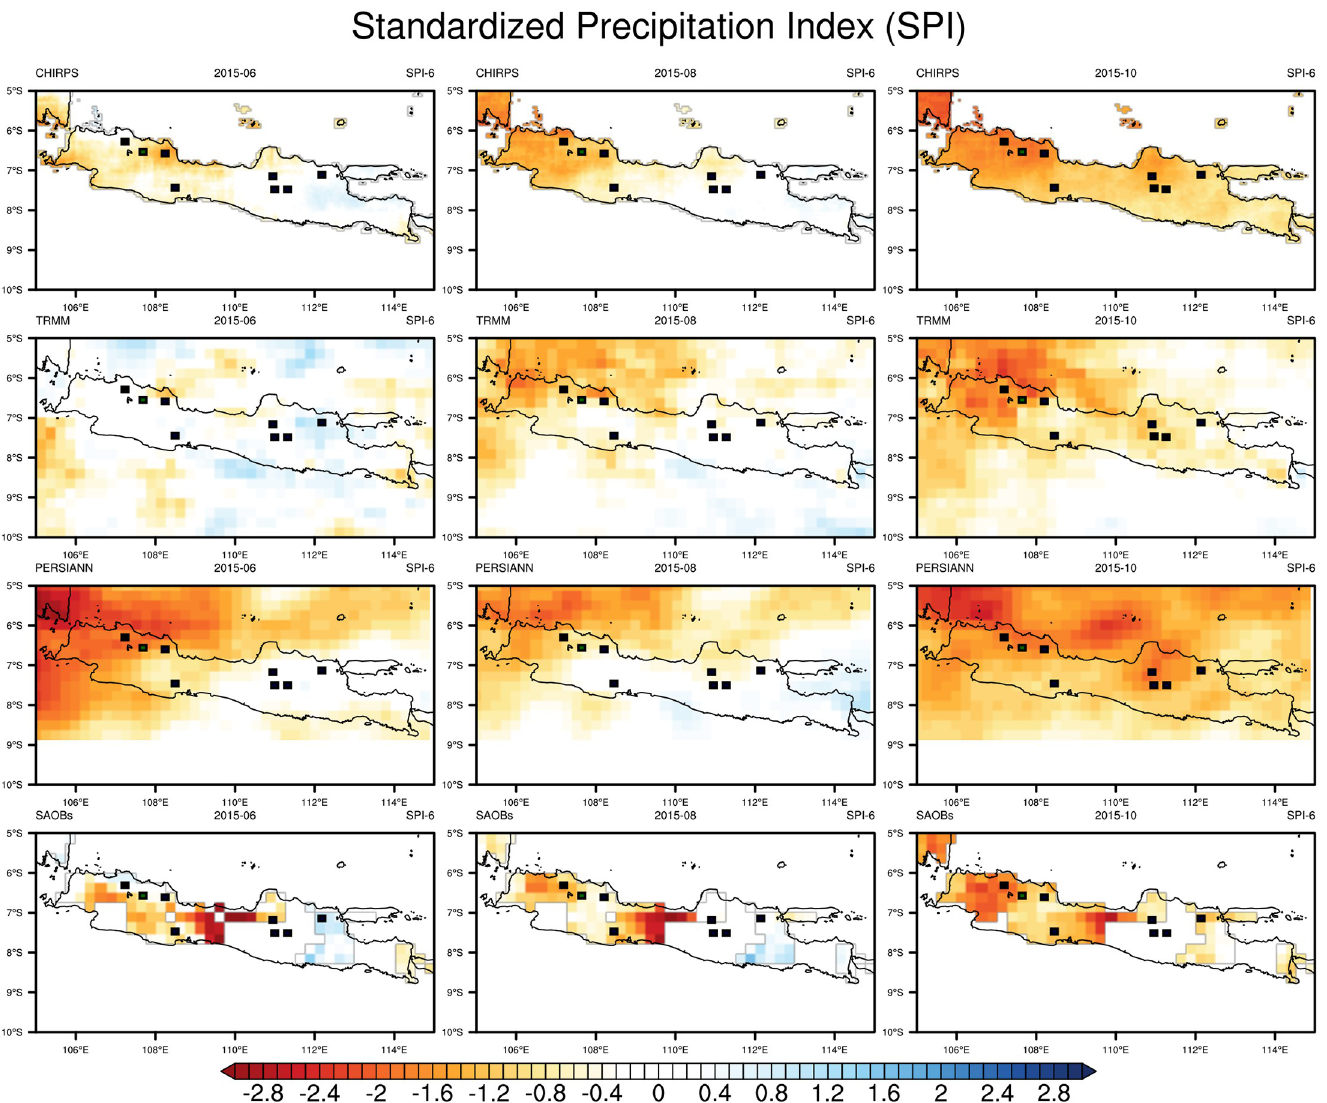
Fig 4. Six-month SPI (SPI-6) derived from CHIRPS, TRMM, PERSIANN, and SA-OBS for June 2015 (left), August 2015 (middle), and October 2015 (right) during the drought event due to the 2015–16 El Ni ñ o. Dots on the map indicate the largest rice-producing districts of